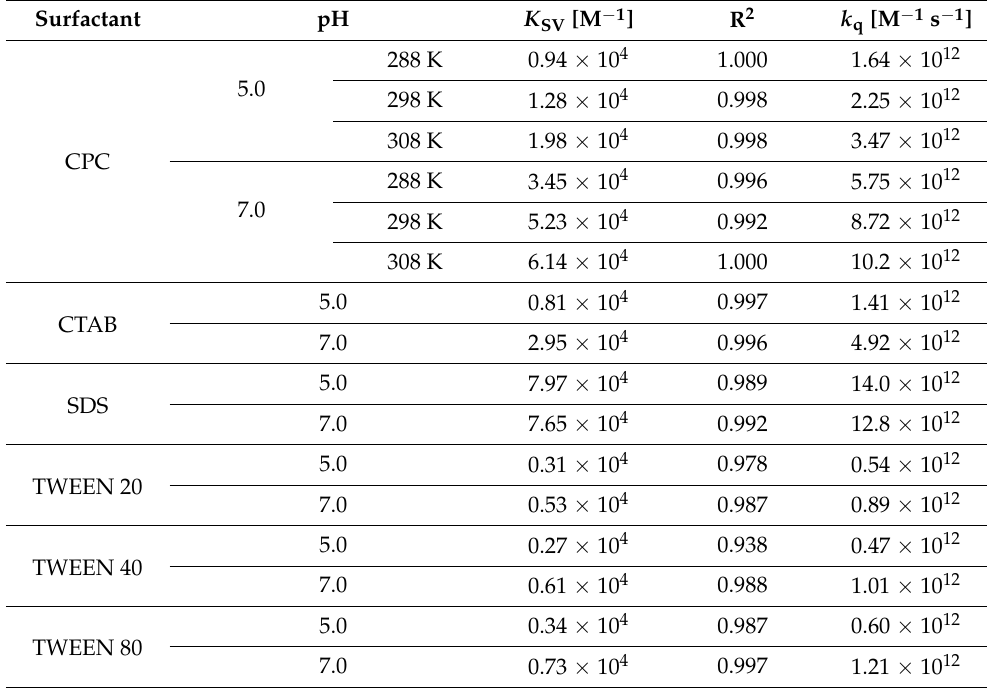
Figure 3. Stern–Volmer plots for the steady-state fluorescence quenching of BSA by CPC in 10 mM CACO buffer of pH 5.0 ( A ) and 7.0 ( B ) at various temperatures (288 K, 298 K, and 308 K). Table 1. Stern–Volmer quenching constants ( K SV ), linear correlation coefficients (R 2 ), and bimolecular quenching rate constants ( k q ) recovered for the steady-state fluorescence quenching of BSA by various surfactants in 10 mM CACO buffer of pH 5.0 and 7.0 at 298 K (for CPC additionally at 288 and 308